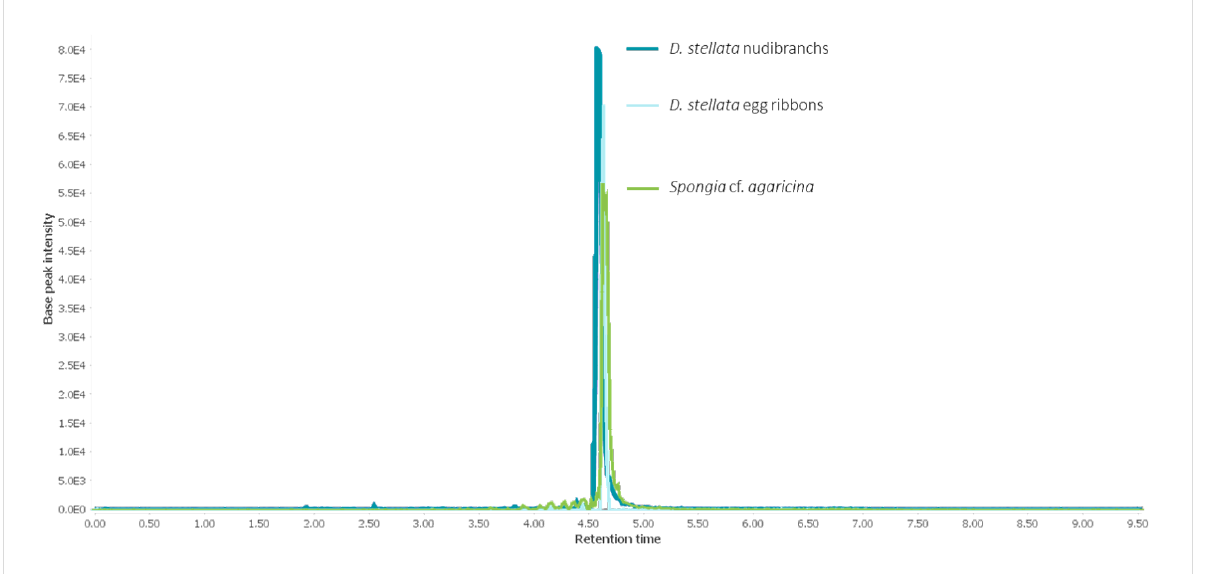
Figure 3: Superimposed HPLC–MS chromatogram of Doriprismatica stellata nudibranch, egg ribbon, and Spongia cf. agaricina extracts, showing the presence of 12-deacetoxy-4-demethyl-11,24-diacetoxy-3,4-methylenedeoxoscalarin in all three samples.